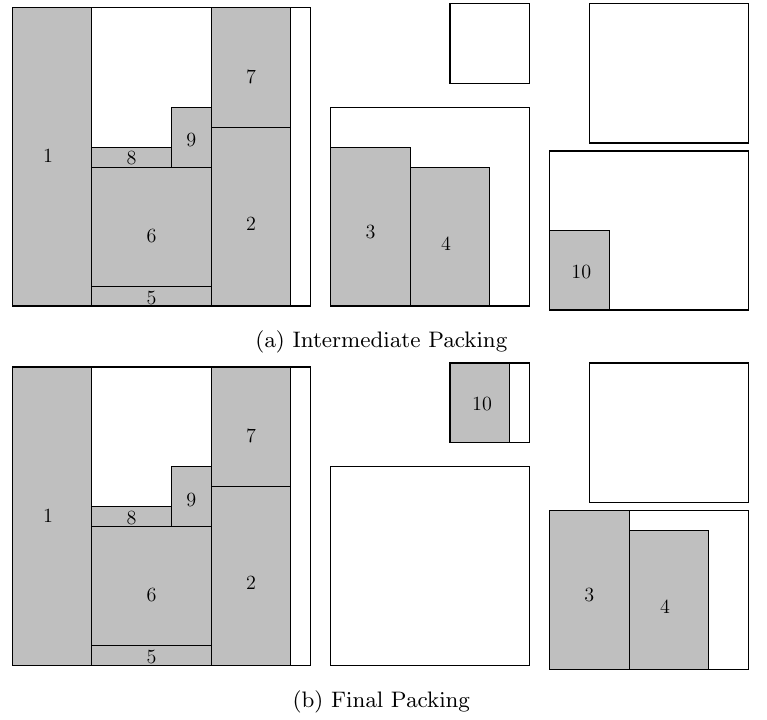
Figure 5: Results obtained by the two-stage algorithm for the VSBPP (2SVSBP-SAS), using the SAS algorithm for strip